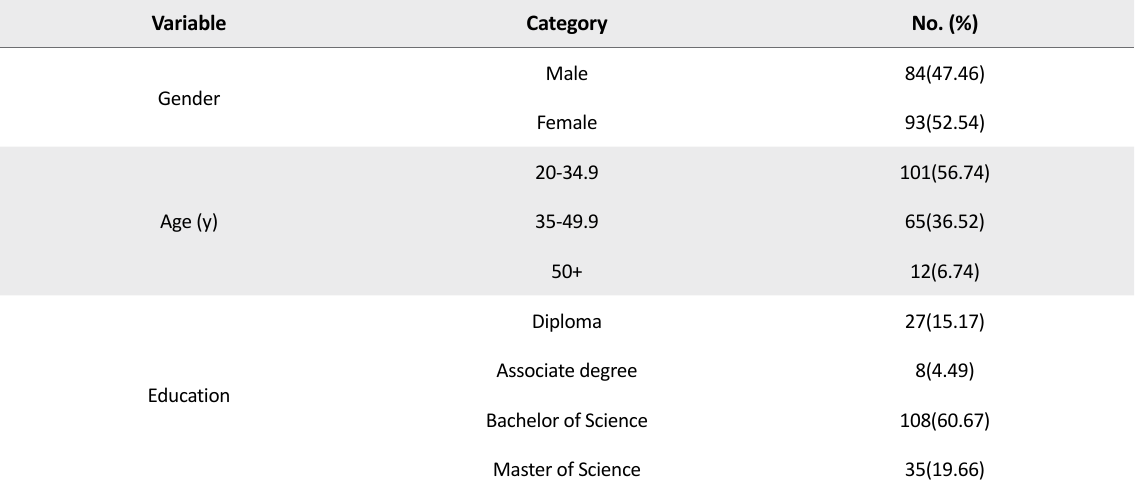
Table 1. Baseline characteristics of studying the